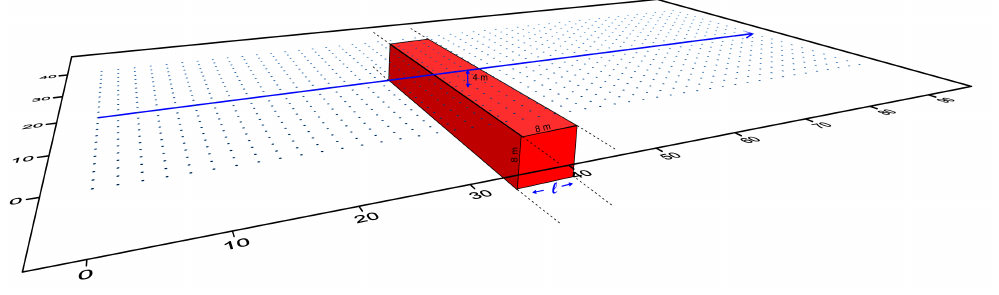
Figure 3. Simulation of a 2D ERT survey (10 5 Ω · m) in a background rock (100 Ω ·